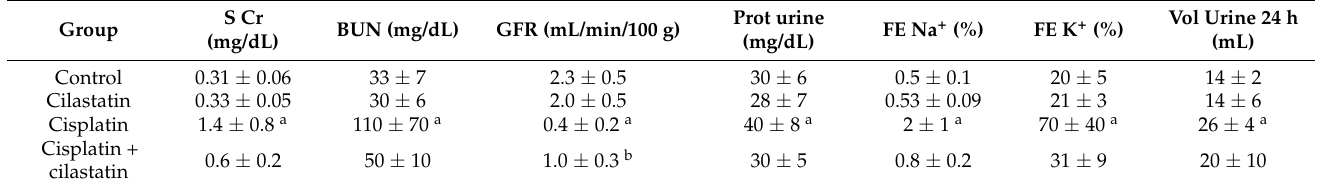
Table 1. Protective effect of cilastatin during cisplatin-induced renal damage. Serum and urine renal function indicators.